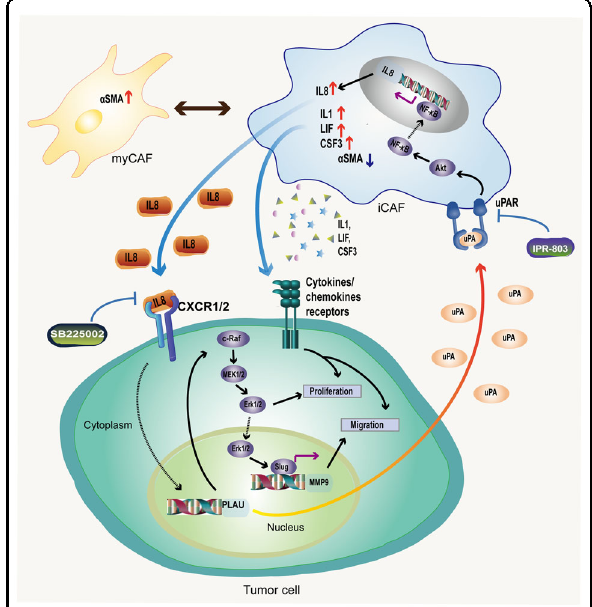
Fig. 8 Research summary: PLAU promotes tumor cells proliferation and migration via MAPK/MEK/Erk/Slug/MMP9. Tumor cell secreted-PLAU promotes the conversion of fi broblasts to iCAFs that facilitate the expression and secretion of IL8 via uPAR/Akt/ NF- κ B, and this activity can be can be blocked by a PLAU-uPAR inhibitor (IPR-803). IL8-secreted by iCAFs upregulates PLAU